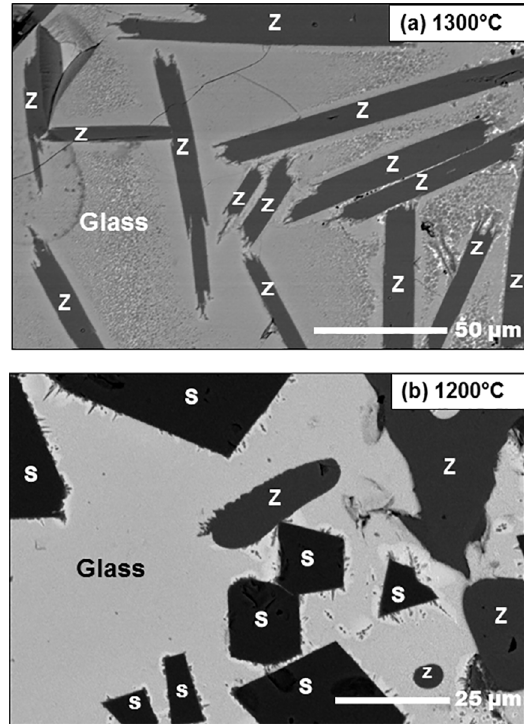
Figure 5. Micrographs of the slag sample 23 equilibrated and quenched from (a) 1300ºC and (b) 1200°C. S: spinel, Z: zincite. Figure 6. Micrographs of the slag sample 24 equilibrated and quenched from (a) 1300°C and (b) 1200°C. S: spinel, Z: